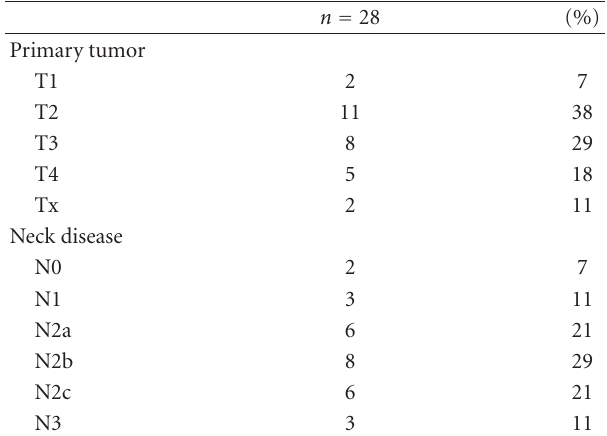
Table 1: Distribution of primary malignancy site. Table 2: Primary staging and nodal status.